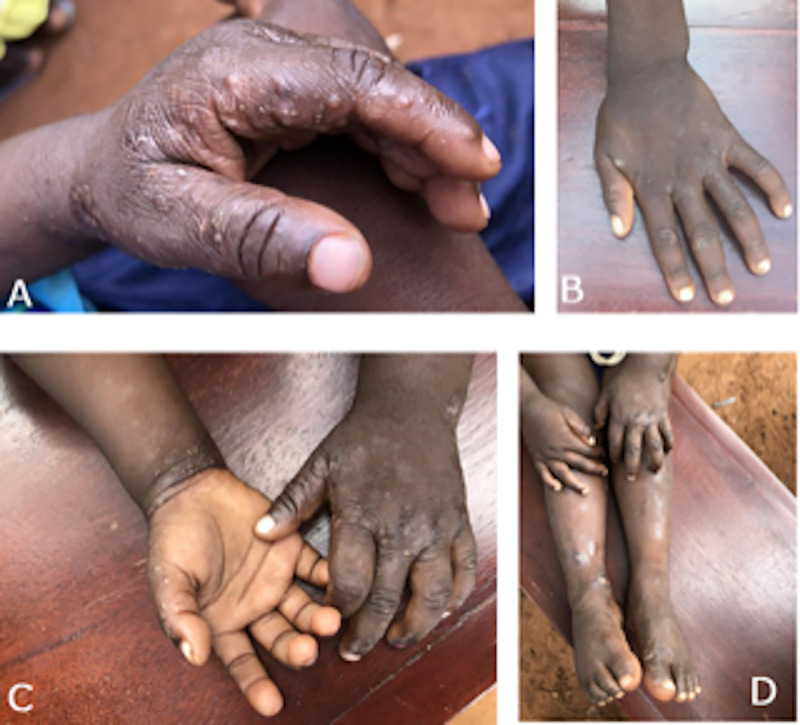
Scabies lesions seen on exposed body regions in four selected participants